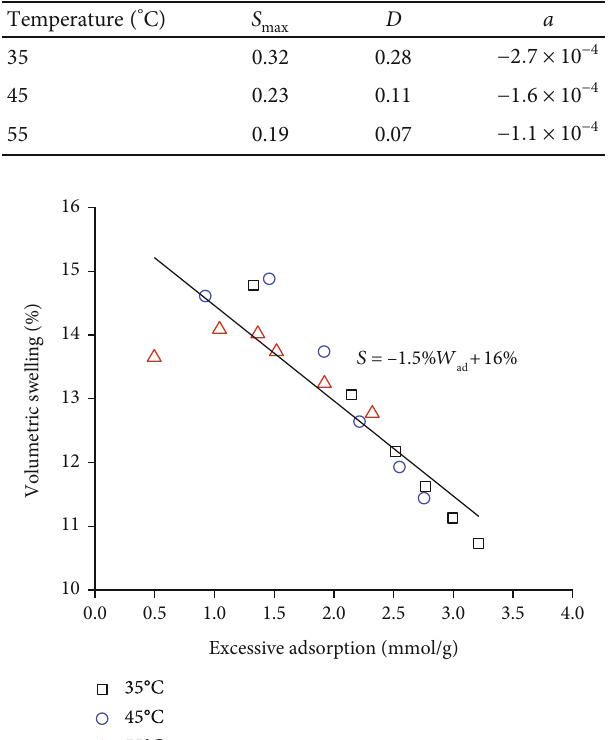
Figure 7: Expansion fi ts with CO Table 1: Fitting parameters for the modi fi ed D-R model.